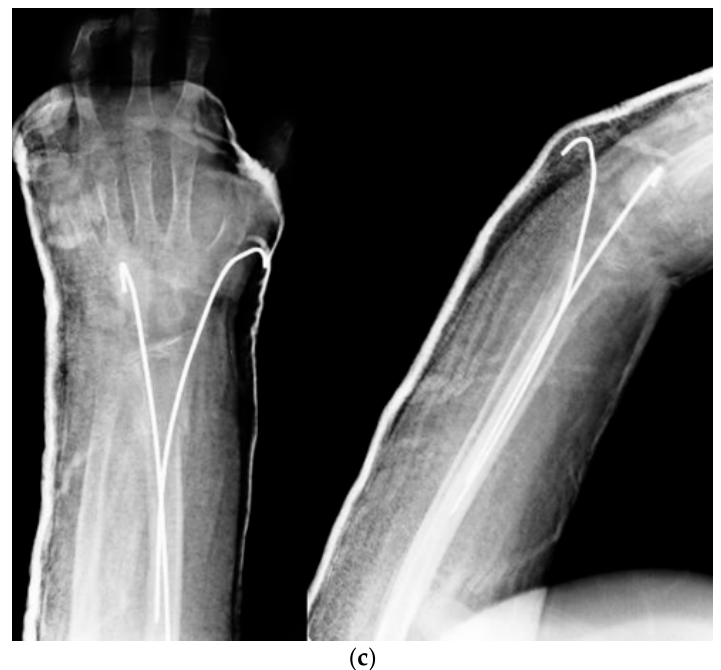
Figure 2. Case report of an obese patient. ( a ) Post-reduction casting X-ray; ( b ) one-week post- reduction X-ray with loss of reduction; ( c ) surgical treatment of the fracture.